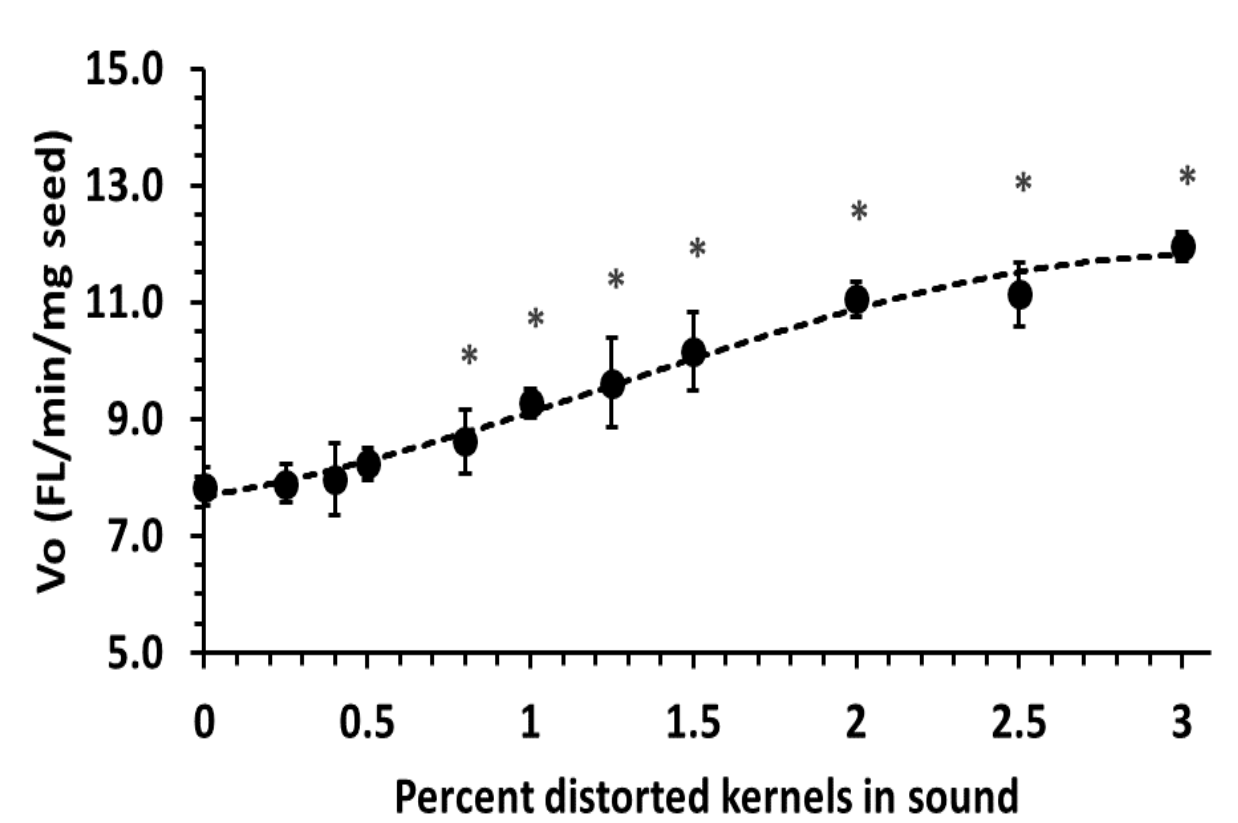
Figure 3. Protease activity, assayed with the fluorescent peptide substrate Mca-R-P-K-V-E-Nval-W-R-K(Dnp)-NH2, for ground seed samples of Fusarium damaged kernels (distorted) in sound (uninfected) base seed. Data points annotated with * are significantly higher than the 0% FDK level (two-tailed t -test, α = 0.05, n = 5).